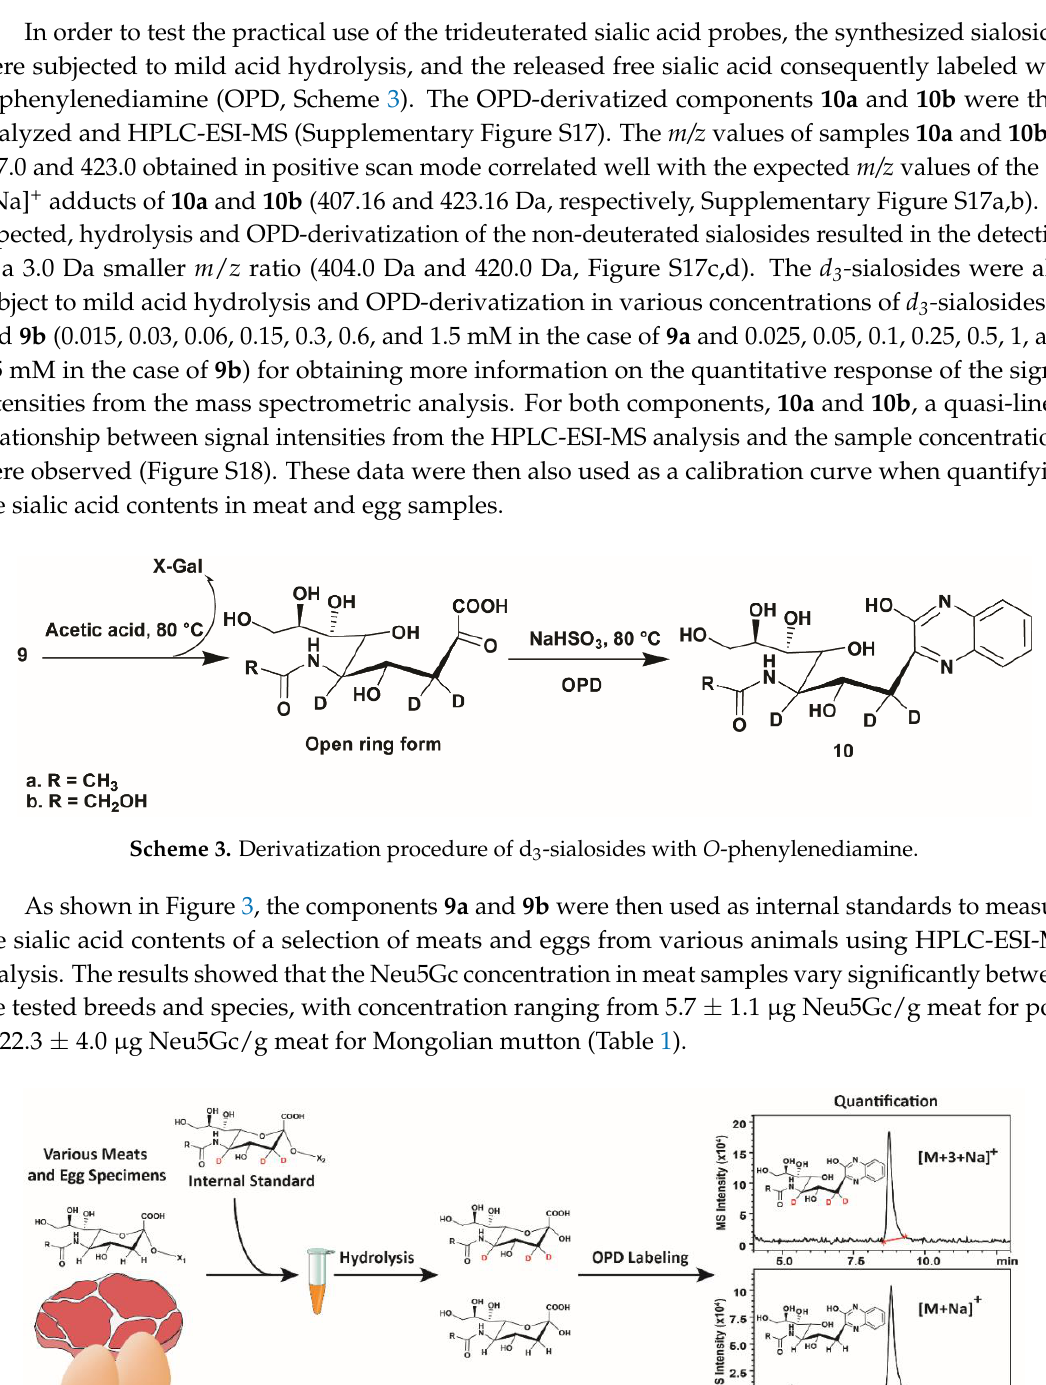
Figure 3. Overview of analyzing the sialic acid concentrations in meat and egg samples using d 3 -sialosides 9a and 9b as internal standards.